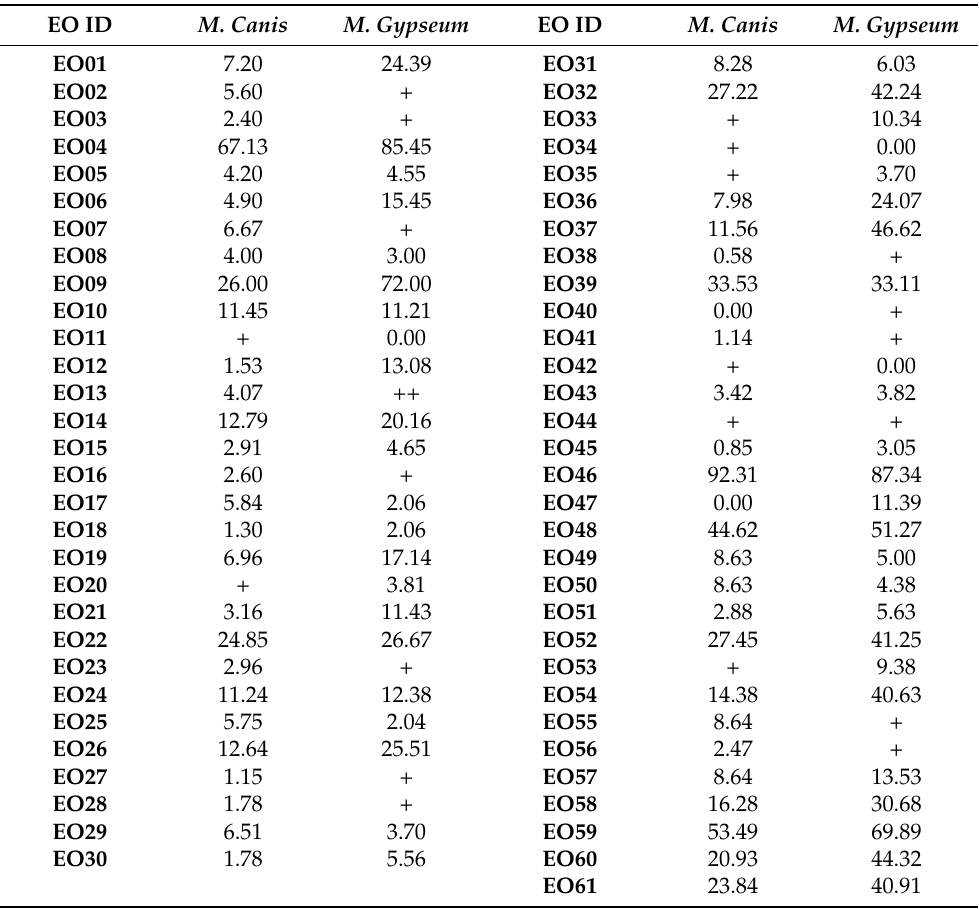
Table 1. Essential oil percentage of M . canis and M . gypseum growth inhibition at 100 µ g/mL; +weak growth, ++ moderate